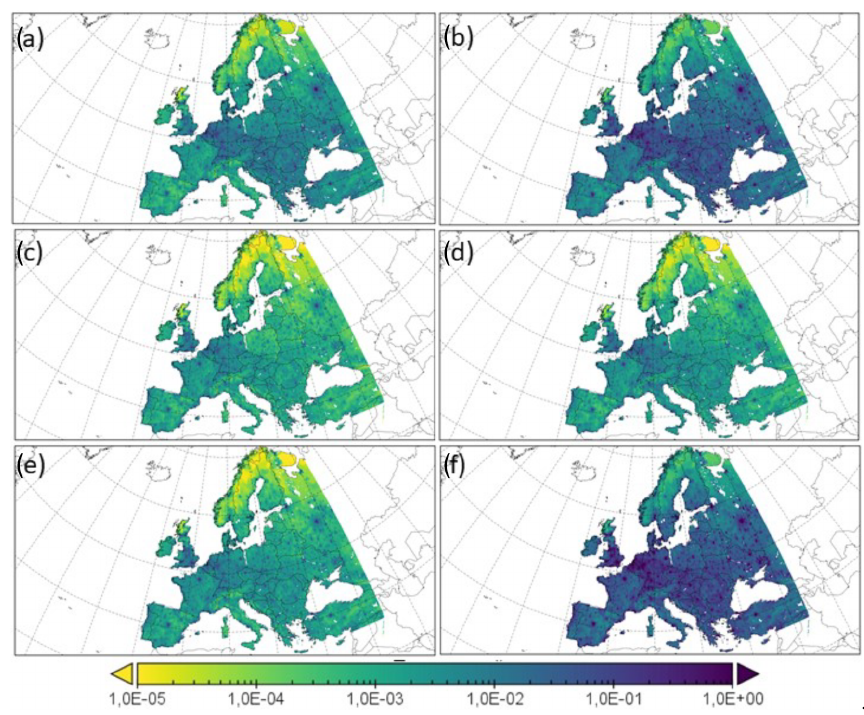
Figure 6. Estimation of PD over Europe for the PRE-P2010 case with different endpoints: (a) CEV, (b) IHD, (c) COPD, (d) LC, (e) LRI and (f) all. All values are in PDkm − 2 per year.